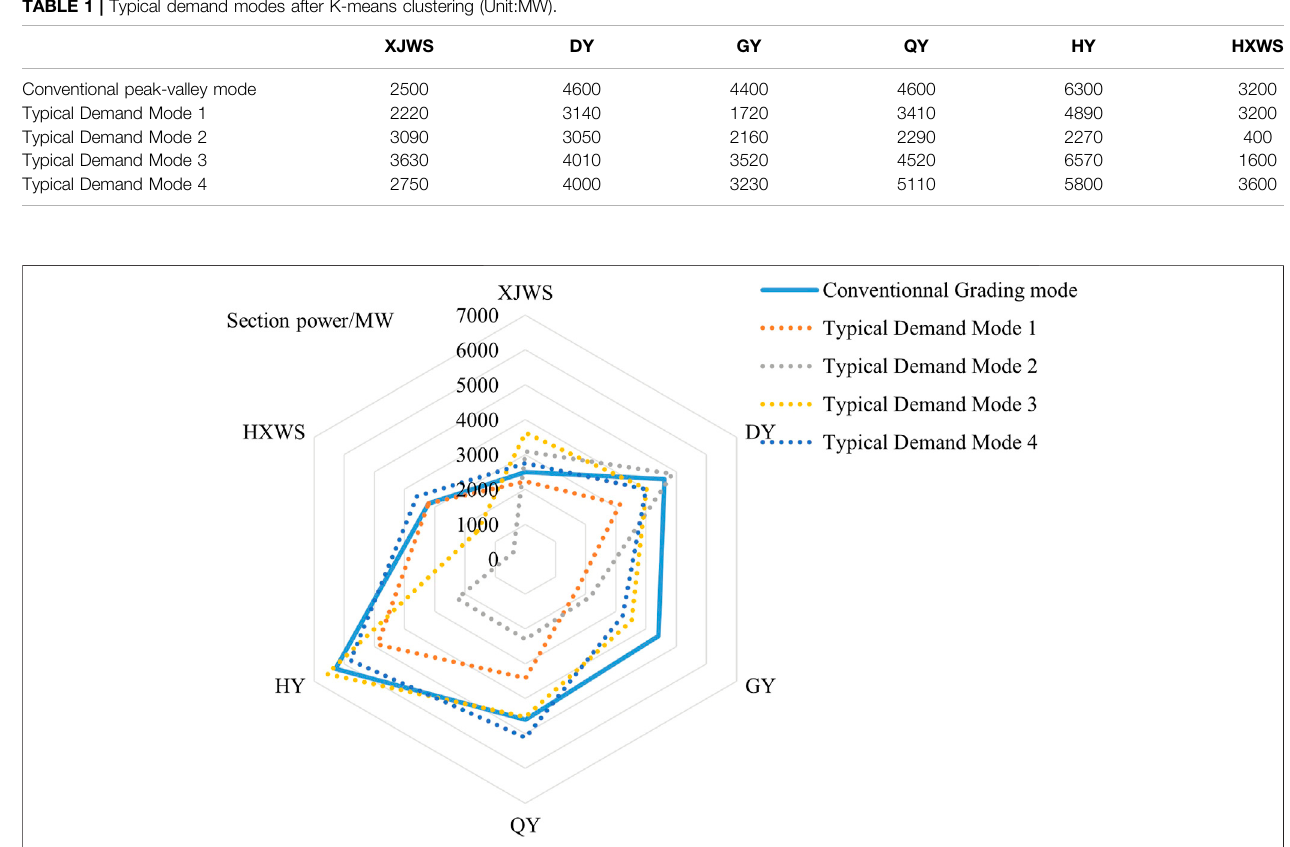
FIGURE 7 | Envelope of the typical demand modes from conventional binning